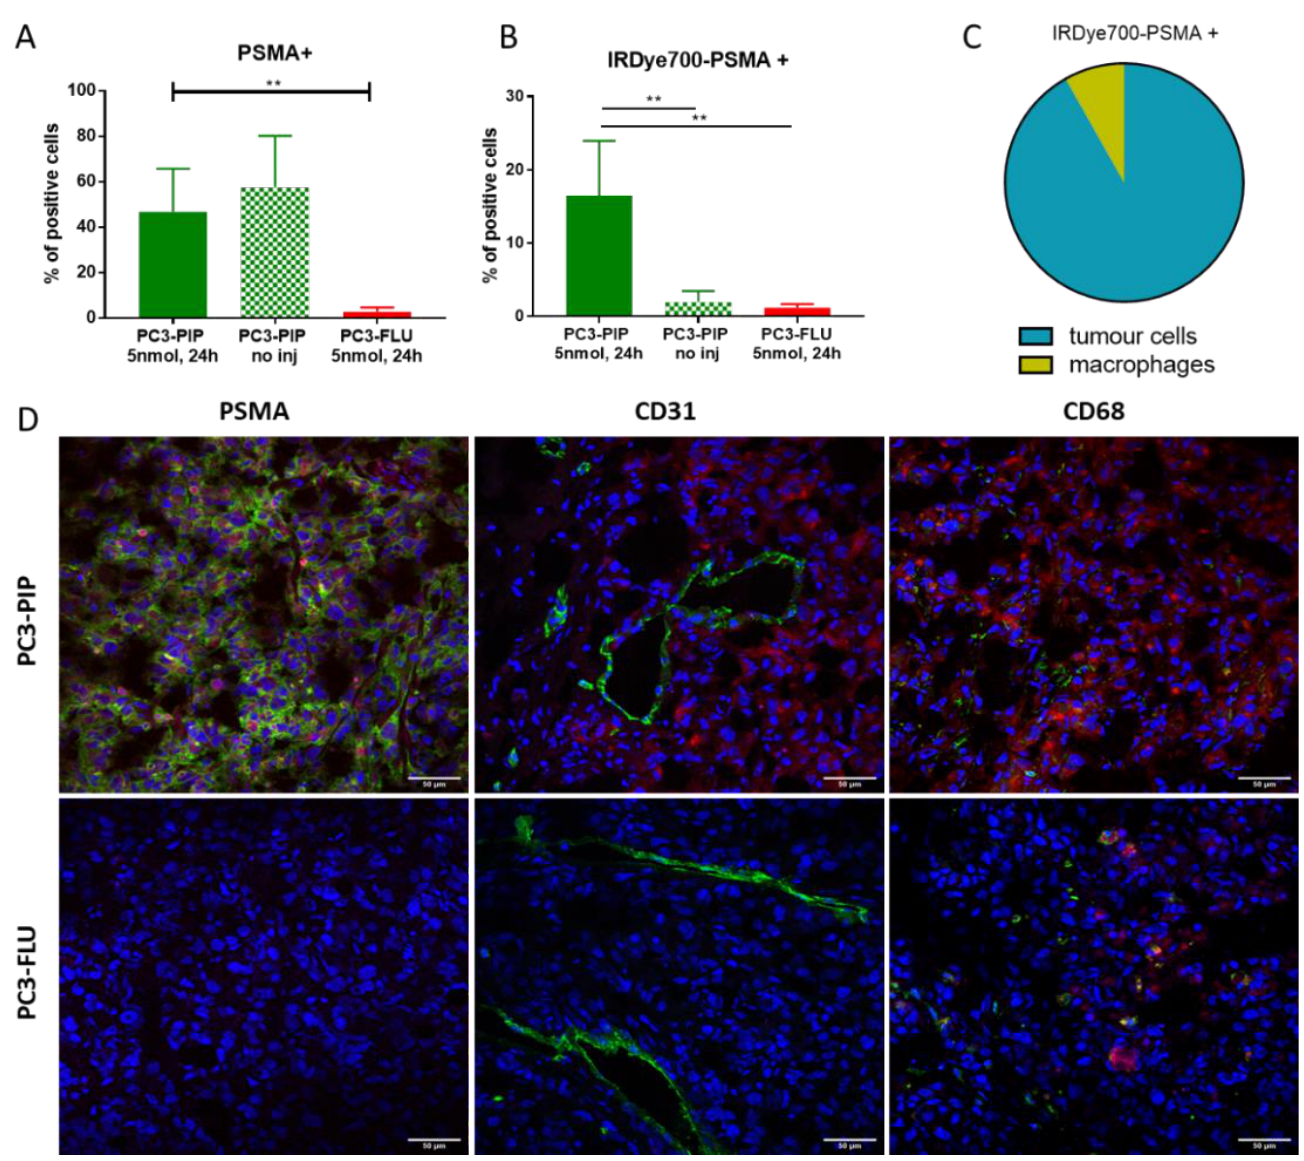
Figure 5. Ex vivo tumour characterization. ( A ) Flow cytometry data of % of PSMA positive cells in PC3-PIP and PC3-FLU tumour tissue. ** p < 0.01, 1-way ANOVA repeated measures followed by Bonferroni post hoc test. ( B ) Flow cytometry data of % IRDye700DX-PSMA positive cells in PC3-PIP and PC3-FLU tumour tissue. ** p < 0.01, 1-way ANOVA repeated measures followed by Bonferroni post hoc test ( C ) Flow cytometry data of IRDye700DX-PSMA cellular distribution in PC3-PIP tumours. ( D ) Confocal fluorescent images of PC3-PIP and PC3-FLU tumours with IRDye700DX-PSMA in red, nuclei in blue and in green PSMA, CD31 or CD68, respectively. Magnification 40×, PI (nuceli) 535 – 617 nm, AlexaFluor488 (PSMA, CD31, CD68) 498 – 577 nm, IRDye700DX 650 – 750.